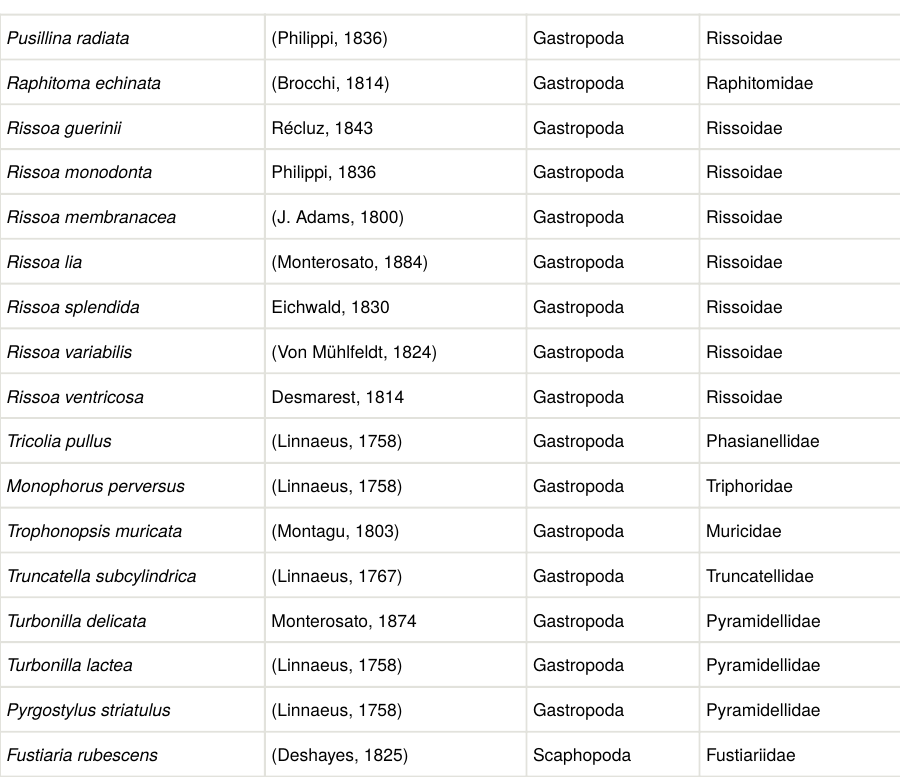
The distribution of species number in the bivalve and gastropod families is presented in Fig. 2 and Fig. 3 respectively. Fustiaria rubescens (Deshayes, 1825), which belongs to the Fustiariidae family, is the only species of tusk shells included in the dataset.